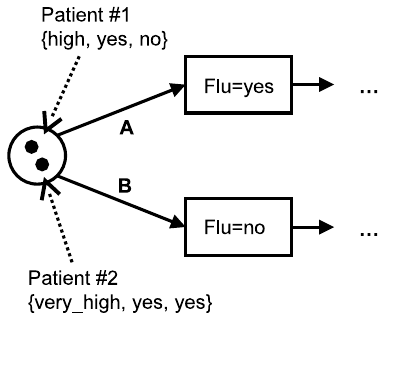
Fig. 3. Diagnosis Decision Tree as Part of a Petri Net.